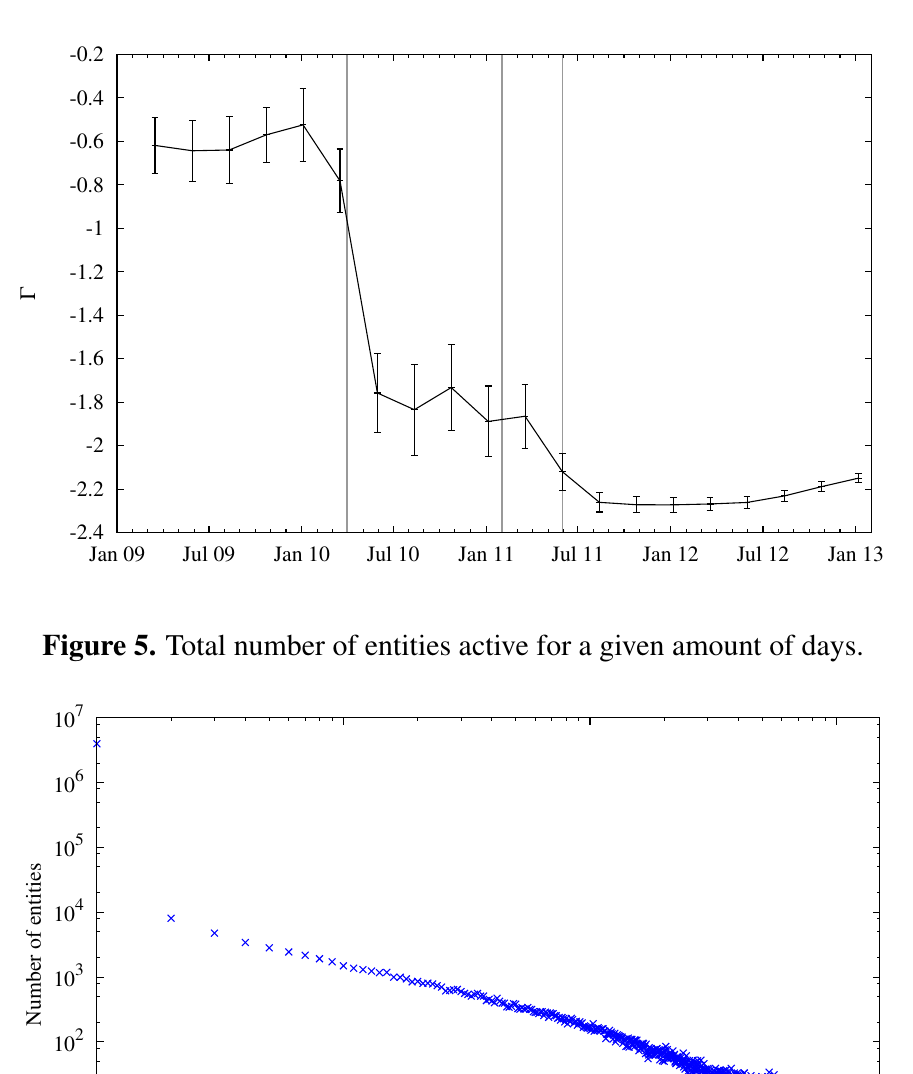
Figure 4. Slope of regression line Γ for entity-size distribution over time. Error bars indicate goodness-of-fit, computed as the root of summed squared residuals between data and a fitted linear model.